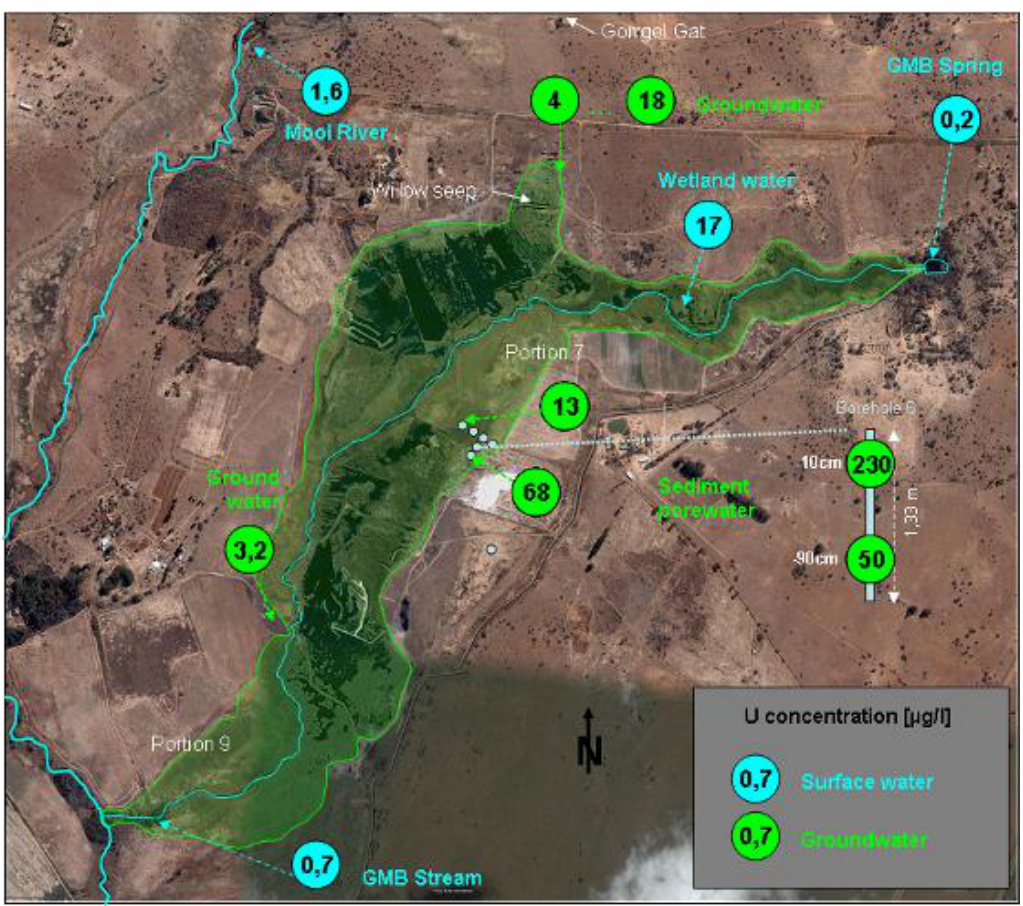
Figure 4. U concentration in surface- and groundwater from the Gerhard Minnebron wetland as found in a screening survey (grab sampling) (map based on satellite image of the study area as retrieved from Google